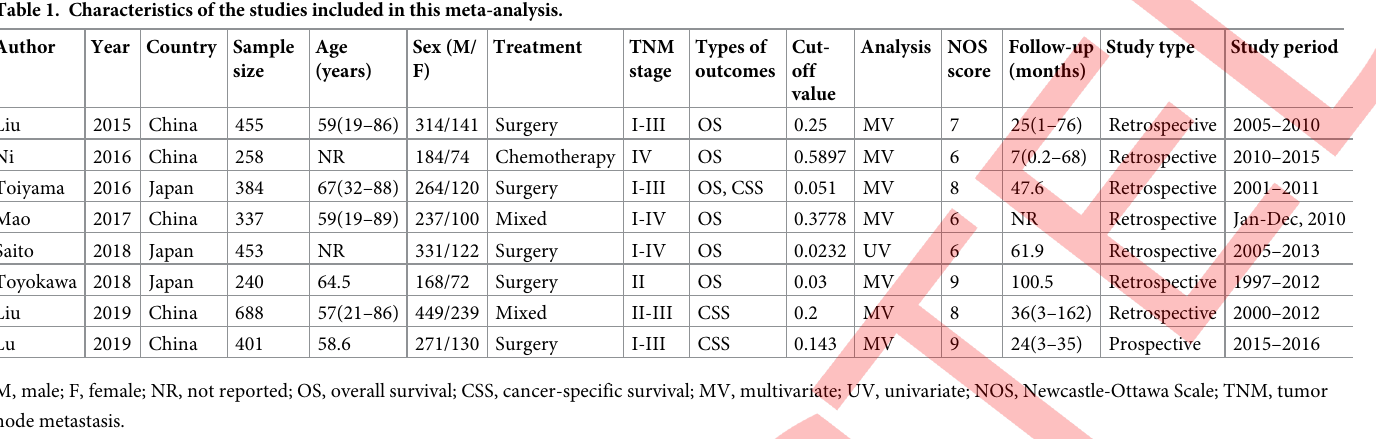
Table 1. Characteristics of the studies included in this meta-analysis.